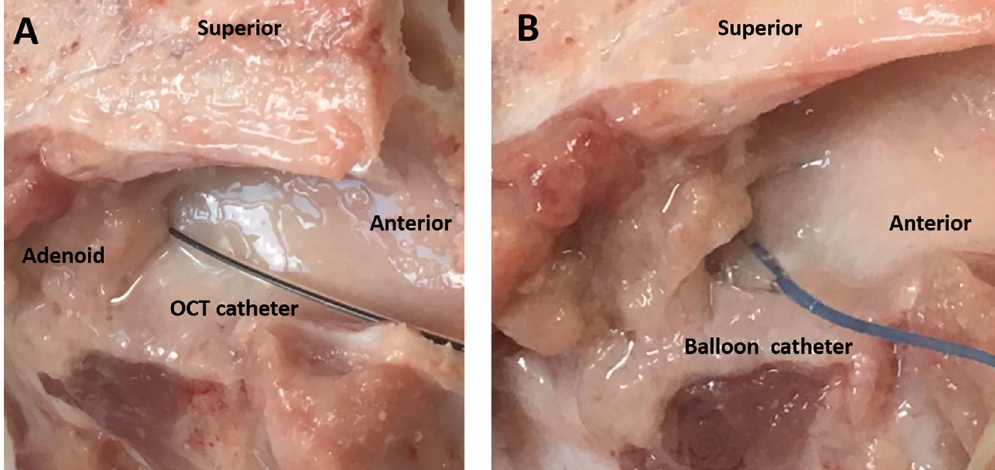
Figure 2. Placement of the optical coherence tomography catheter ( A ) and balloon catheter ( B ) through the left nasopharyngeal opening of the swine Eustachian